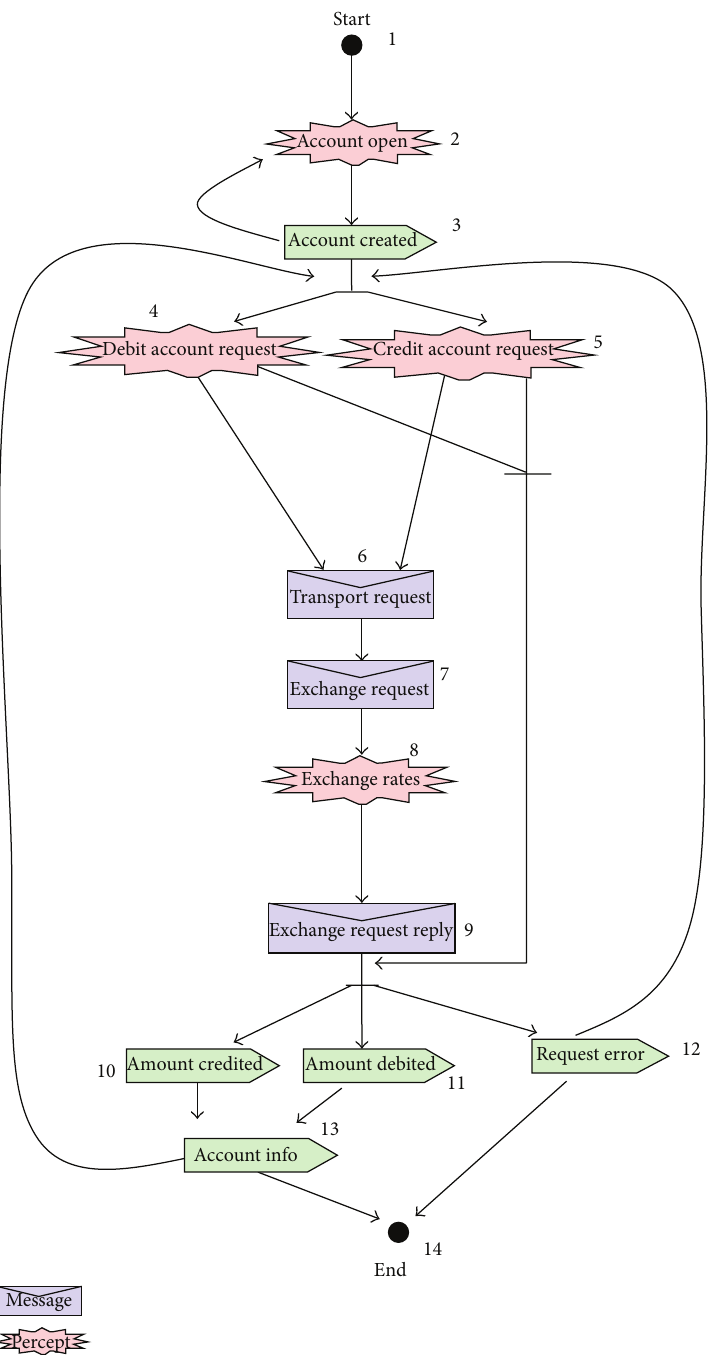
Figure 7: Protocol graph for account operation protocol